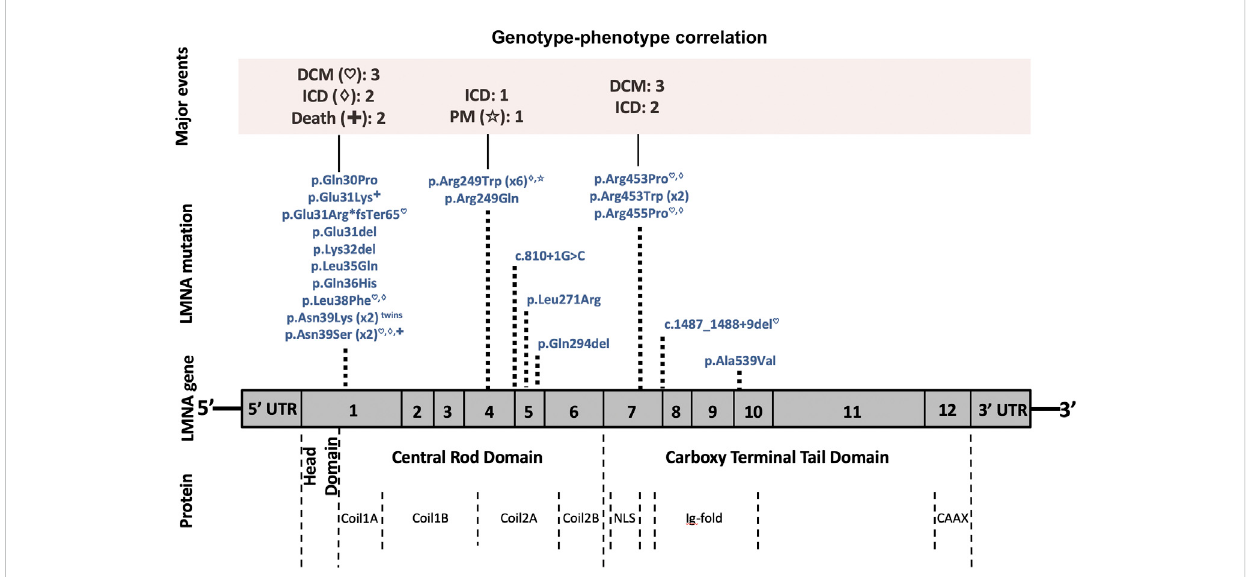
FIGURE 5 Phenotype – genotype graphic correlation. A schematic representation of the LMNA gene is shown. Top, major cardiac events, followed by rare pathogenic/likely pathogenic LMNA variants identi fi ed in our patients with the corresponding amino acid or nucleotide changes. Bottom, structural protein:thecoil1A – 1Bandcoil2A – 2Bconstitutingthe ⍺ -helicalroddomain.Abbreviations:DCM,dilatedcardiomyopathy;ICD,implantablecardioverter de fi brillator; PM, pacemaker; NLS, nuclear location signal; Ig,